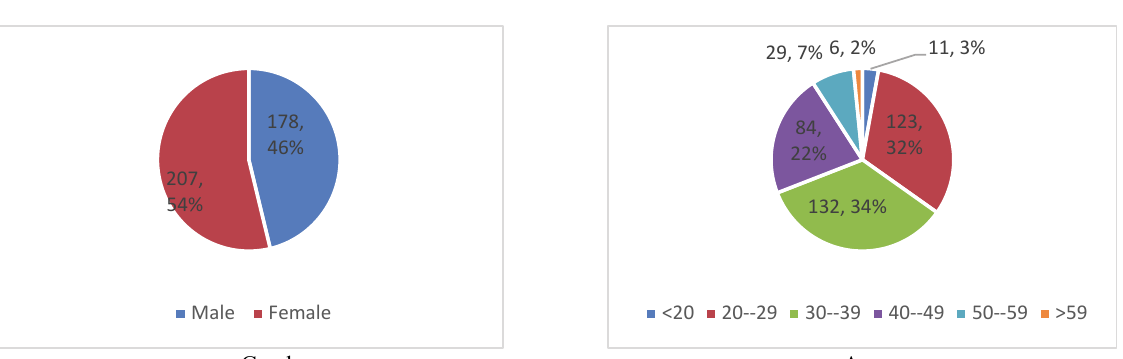
Fig. 1. Demographic characteristics of the